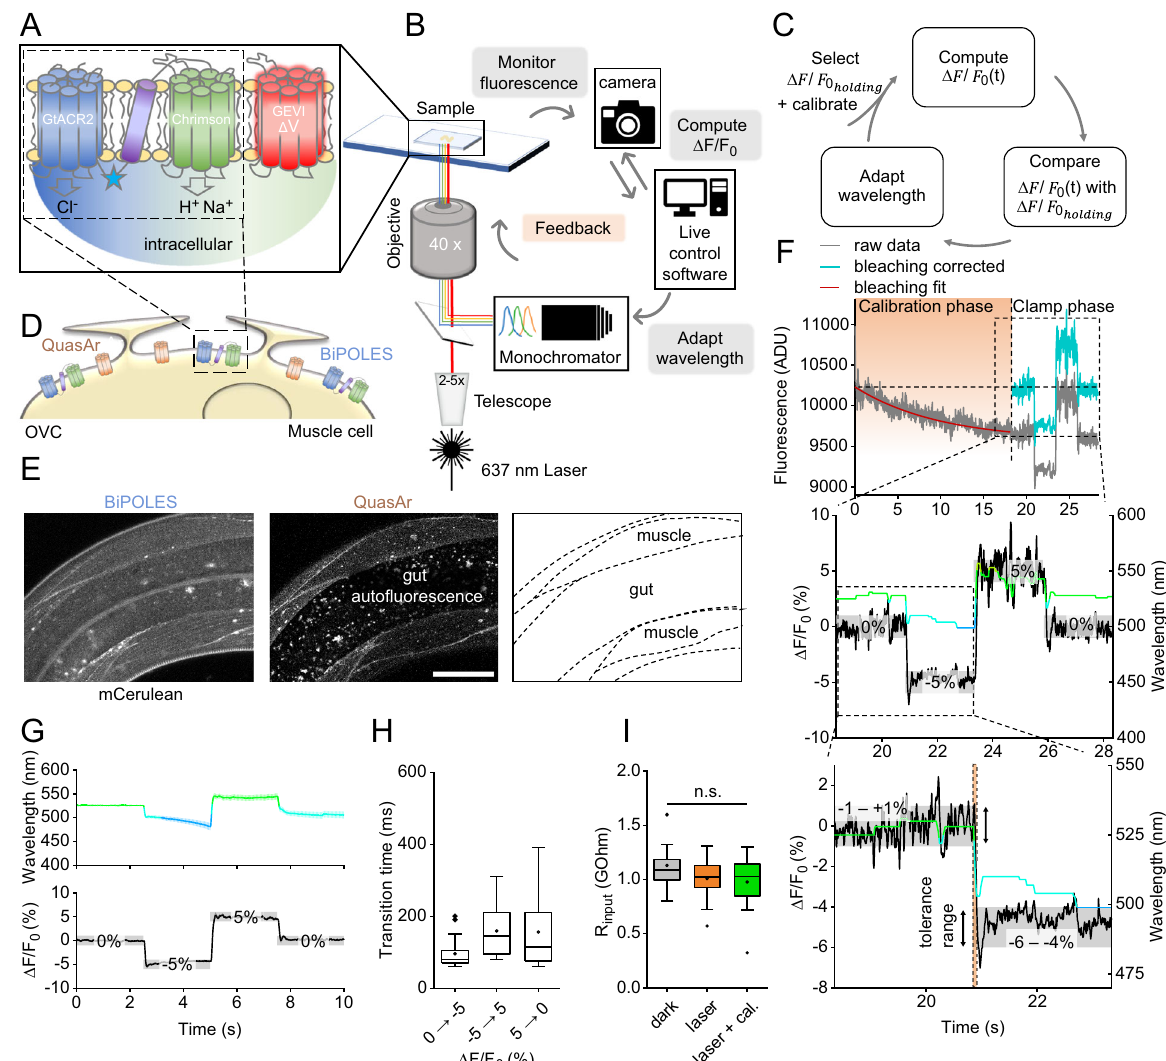
Fig. 1 | Components, setup, and functionality of the OVC. A Molecular OVC components: Two counteracting optogenetic actuators for de- and hyperpolar- ization (GtACR2, Chrimson; blue star: mCerulean), and a voltage indicator. B Hardware setup and communication: Membrane voltage is monitored via a fast andsensitive(sCMOSorEMCCD)camera;grayvaluesareprocessedbylivecontrol software(SupplementaryCode1).Basedonthedifferencetothesetholdingvalue, a feedback of light from a monochromator is sent to the optogenetic actuators. C OVC feedback mechanism: After selection of clamping parameters and calibra- tion for bleaching correction, Δ F / F 0 is calculatedand compared with the set value, toadaptthewavelengthaccordingly,inclosed-loop. D OVC(QuasAr2andBiPOLES) inBWMs. E Confocal fl uorescence z -projection.BiPOLES(mCerulean)andQuasAr2 in BWM membranes, scheme (dashed lines represent muscle plasma membranes). Scale bar, 50 µ m. Representative image (from n =22). F OVC four-step protocol